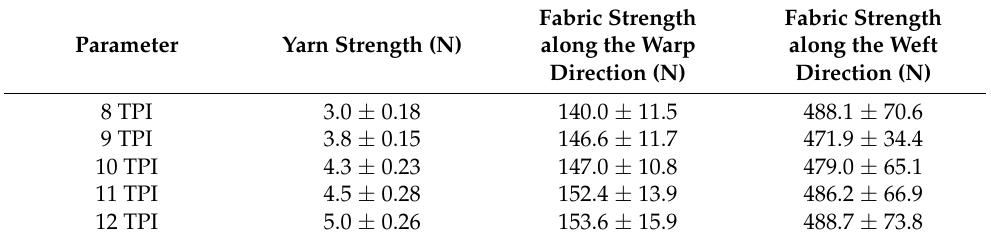
Table 2. Tensile strength of non-woven fabrics as related to the TPI of constituent core-spun yarns.